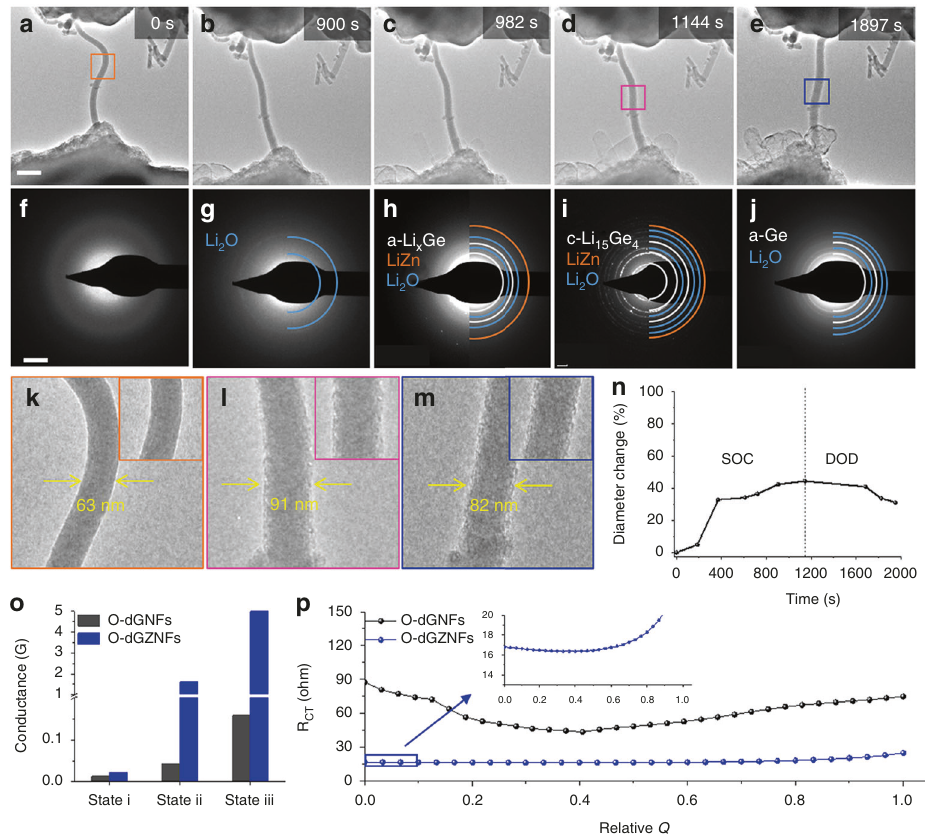
Fig. 5 In situ characterization of O-dGNFs and O-dGZNFs. In situ TEM observations were conducted with an O-dGZNF sample. Time-resolved TEM images for a – d lithium insertion and e lithium extraction in real time. f – j Each SAED pattern corresponds to the TEM image above. k – m Magni fi ed TEM images of featured states. n Curve of diameter change vs. time upon lithiation/delithiation. o In situ electrical conductivity measurement of O-dGNFs and O-dGZNFs during the lithiation process at three points, marked as state i, ii, and iii and corresponding to f , g , and i , respectively. p In situ EIS galvanostatic measurements during lithiation at 1.0 C-rate of O-dGNFs and O-dGZNFs. Scale bars: a 200 nm and f 5